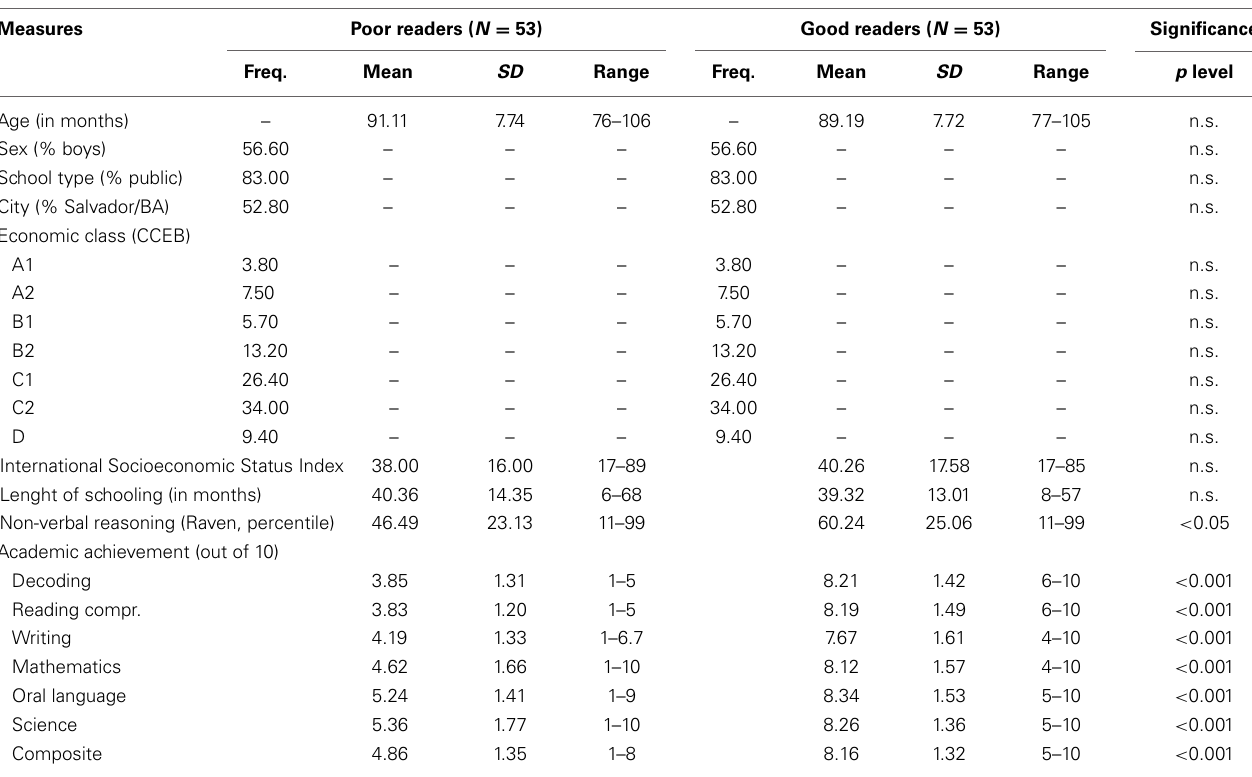
Table 1 | Descriptive characteristics of the sample according to